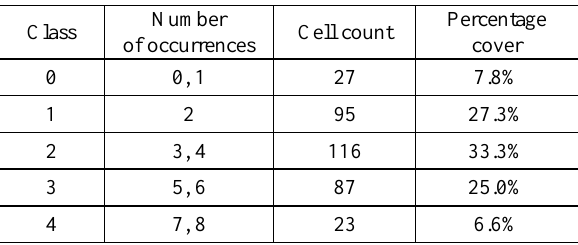
Table 4. Classification of occurrence map: cell count and percentage cover for the five classes.